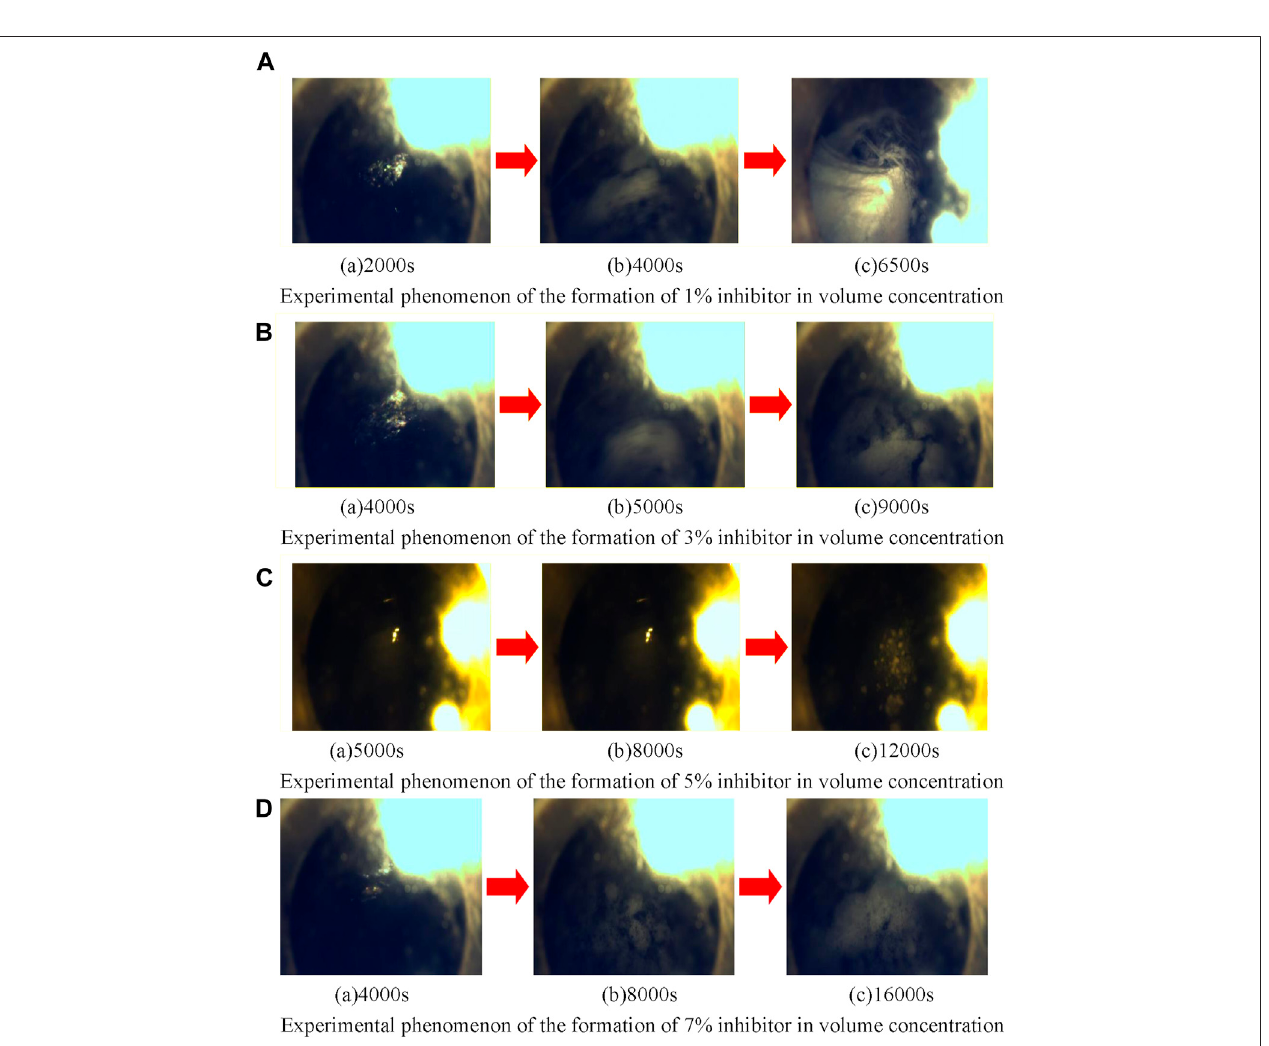
FIGURE 5 | Experimental phenomena of methane hydrate formation under different inhibitor volume concentrations. (A) Experimental phenomenon of the formationof1%inhibitorinvolumeconcentration. (B) Experimentalphenomenonoftheformationof3%inhibitorinvolumeconcentration. (C) Experimentalphenomenon of the formation of 5% inhibitor in volume concentration. (D) Experimental phenomenon of the formation of 7% inhibitor in volume concentration.